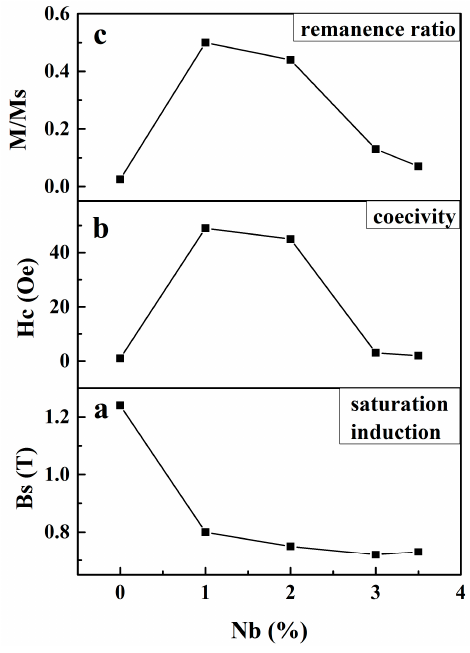
Figure 12. The content of Nb dependence of Bs ( a ), Hc ( b ), and Mr/Ms ( c ).